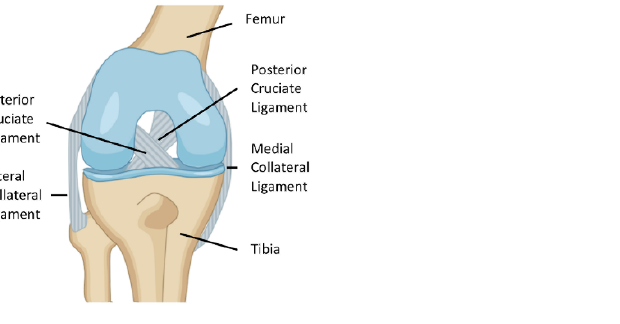
Figure 1. Knee key ligaments (anterior cruciate ligament—ACL, posterior cruciate ligament—PCL, medial collateral ligament—MCL, lateral collateral ligament—LCL).